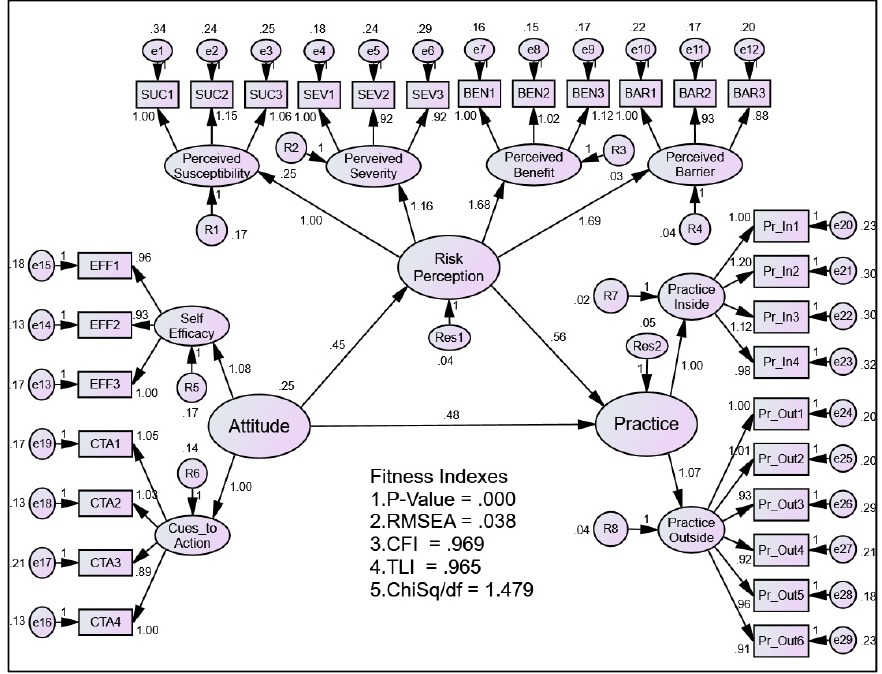
Figure 5. The results for regression coefficient between constructs.